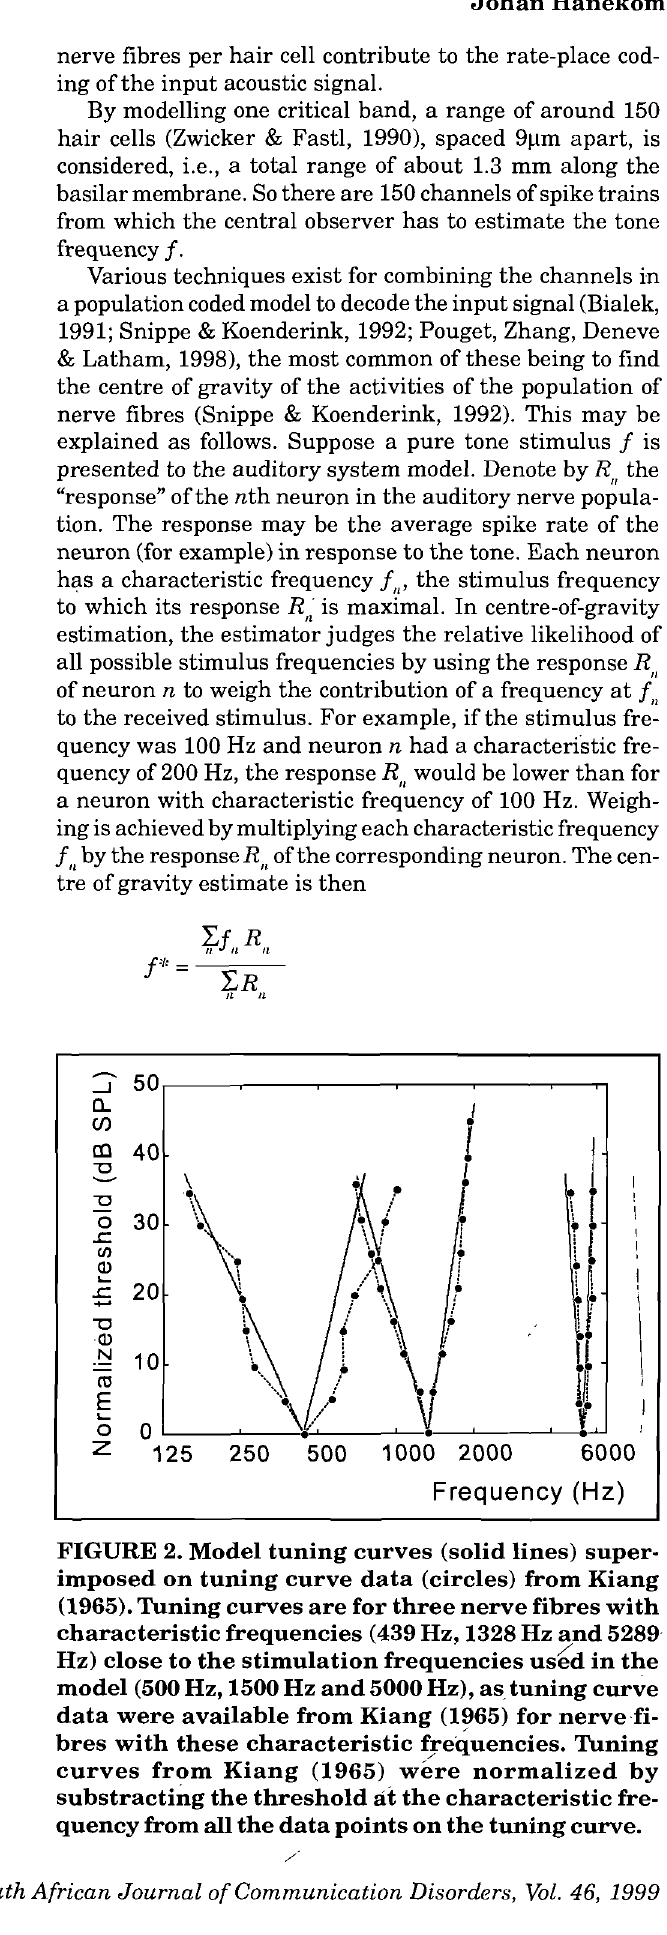
FIGURE 2. Model tuning curves (solid lines) super imposed on tuning curve data (circles) from Kiang (1965). Tuning curves are for three nerve fibres with characteristic frequencies (439 Hz, 1328 Hz and 5289 Hz) close to the stimulation frequencies us'd in the model (500 Hz, 1500 Hz and 5000 Hz), as. tuning curve data were available from Kiang (1965) for nervefi bres with these characteristic fre<luencies. Tuning curves from Kiang (1965) w~re normalized by substracting the threshold at the characteristic fre quency from all the data points on the tuning